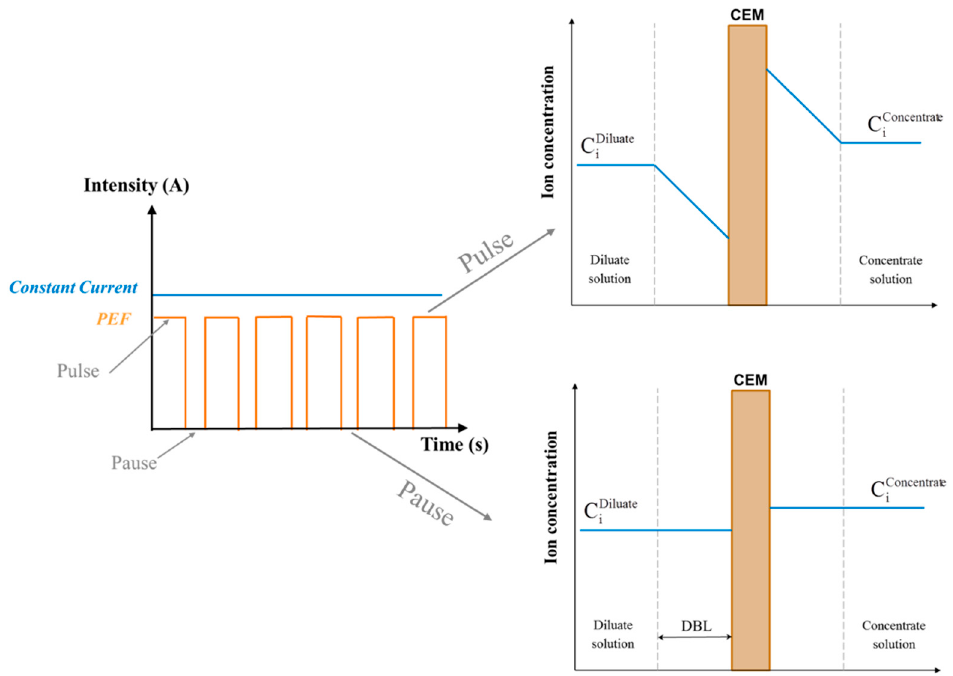
Figure 12. Principle of pulsed electric field (PEF) and effect on concentration polarisation. CEM: cation-exchange membrane; DBL: diffusion boundary layer.